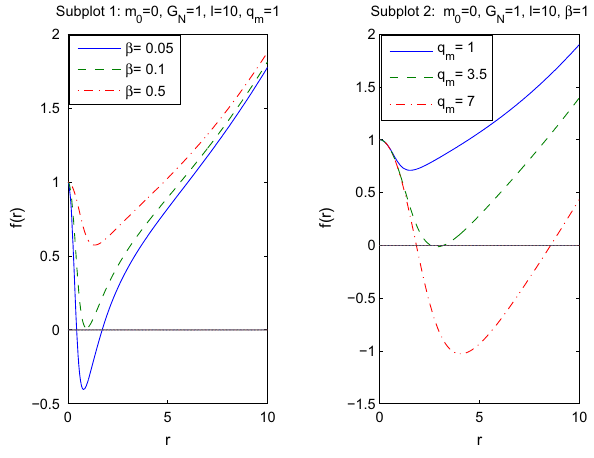
Fig. 1 The plot of the function f ( r ) at m 0 = 0, G N = 1 and l =